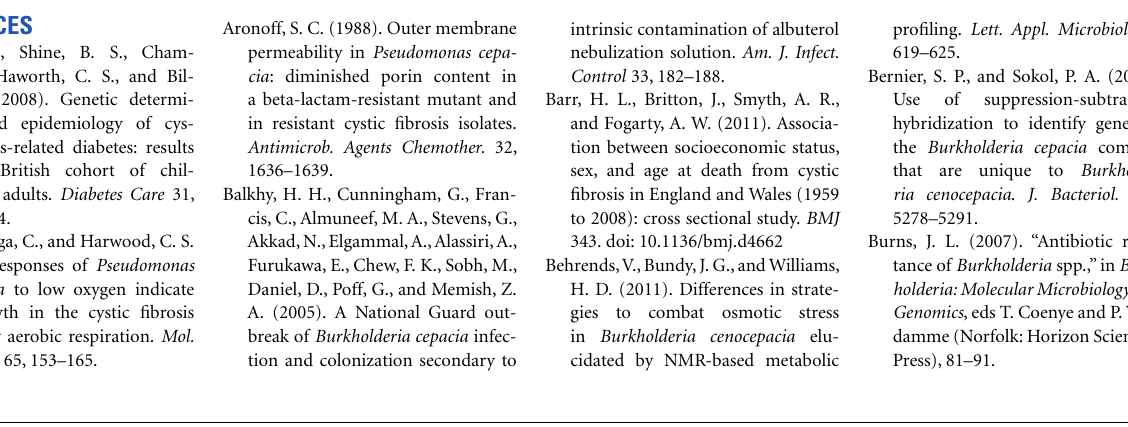
FIGURE 4 | Proposed mechanistic model of the adaptive responses that might occur during long-term residence of B. cenocepacia in the stressing environment of the CF lung under antimicrobial therapy. The